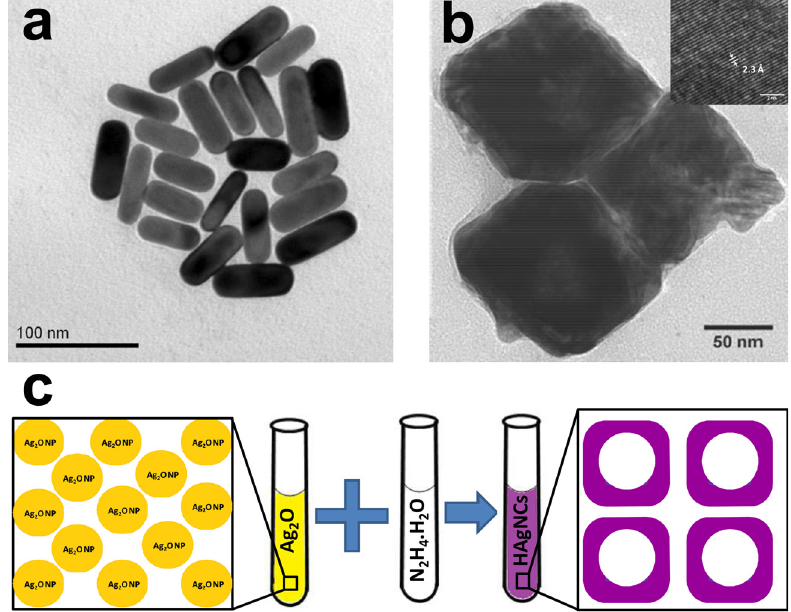
Figure 3: ( a ) Transmission electron microscopy ( TEM ) images of Au NRs, reproduced with permission [ 118 ] . Copyright 2019, Royal Society of Chemistry. ( b ) HRTEM image of HAgNC - 630 and ( c ) synthesis scheme of HAgNCs, reproduced with permission [ 119 ] . Copyright 2018, American Chemical